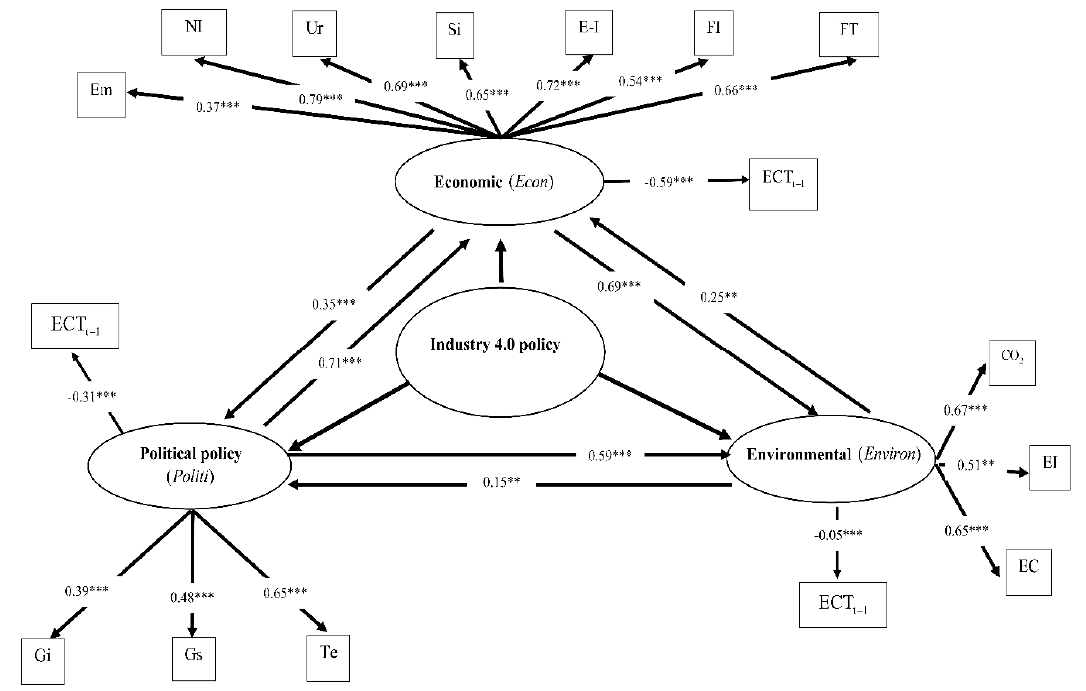
Figure 6. The casual relationship in the Second Order Autoregressive-SEM .